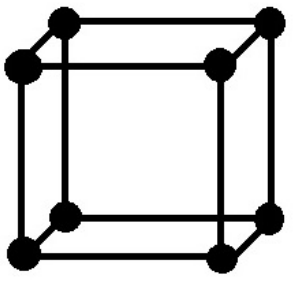
Figure 1. Crystal Structure Cubic Carbon CCC ( 1 ) .